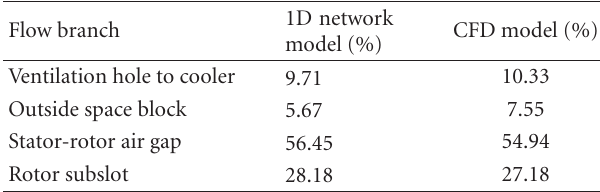
Table 1: Comparison of flow distribution between 1D network model and CFD